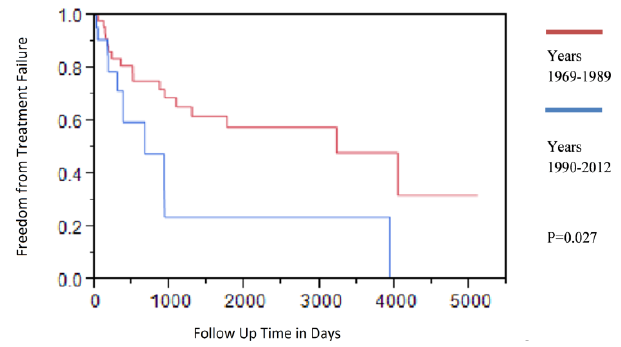
Figure 3. Kaplan-Meier time dependent analysis of Pseudomonas PJI, based on time period. Patients treated between 1969-1989 had a better outcome than those treated between 1990-2012 time period.